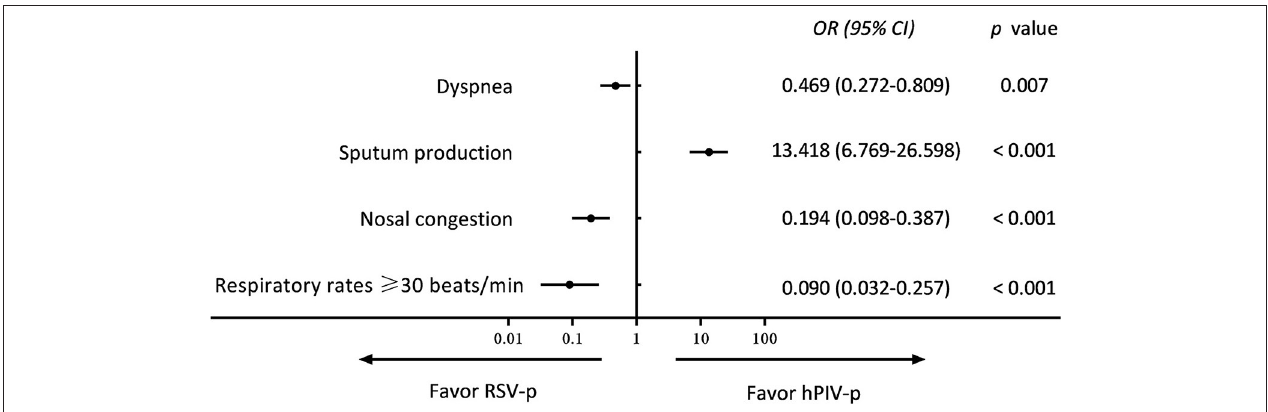
FIGURE 3 | Multivariate analysis of predictors for hPIV-p (compared with RSV-p).